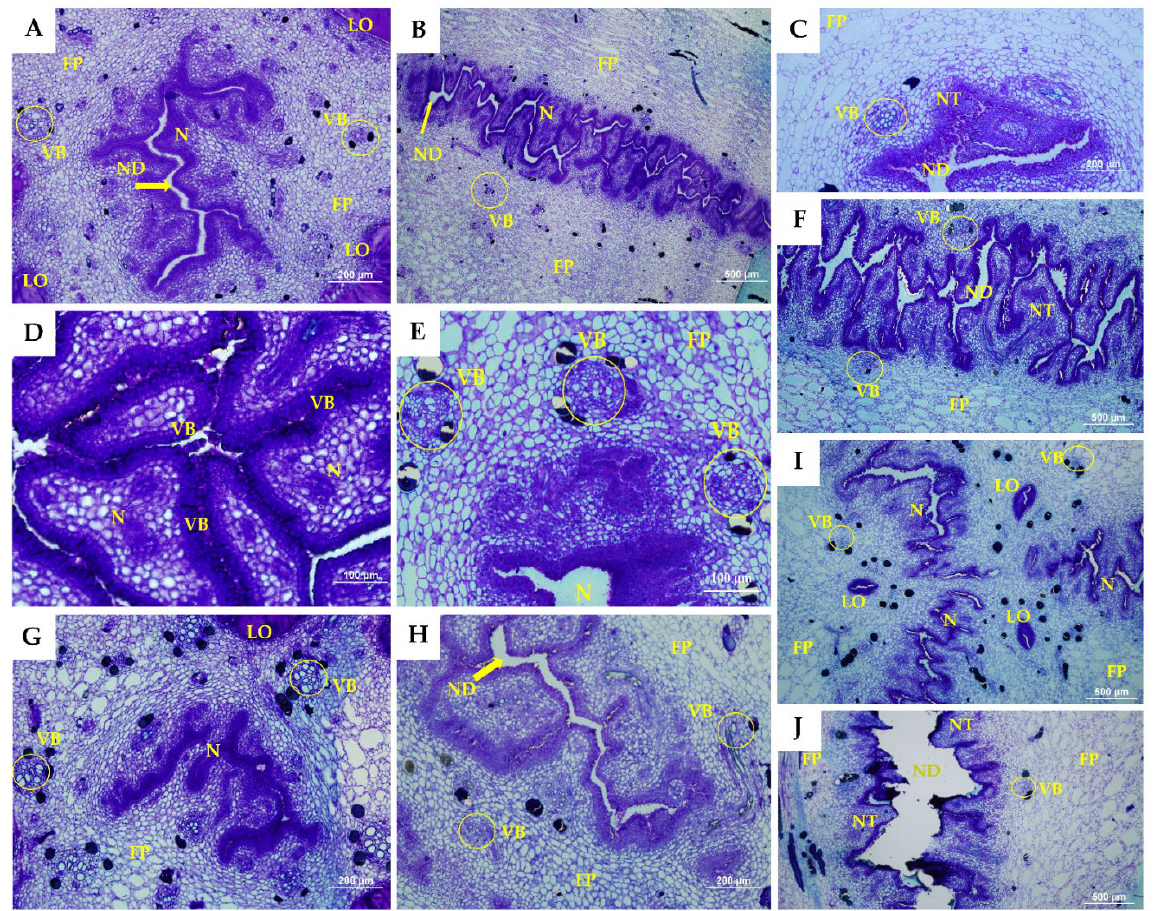
Figure 3. Section of developmental stages of the septal nectaries of Grand Naine. Longitudinal sections: ( A , C , E , G , I ). Cross-sectional sections: ( B , D , F , H , J ). ND, nectariferous duct; VB, vascular bundle; LO, loculus; N, nectary; FP, fundamental parenchyma; PP, pluristratified papillae; NT, nectariferous tissue. The white bars represent 100 µm ( D , E ), 200 µm ( A , C , G , H ) and 500 µm ( B , F , I , J ).